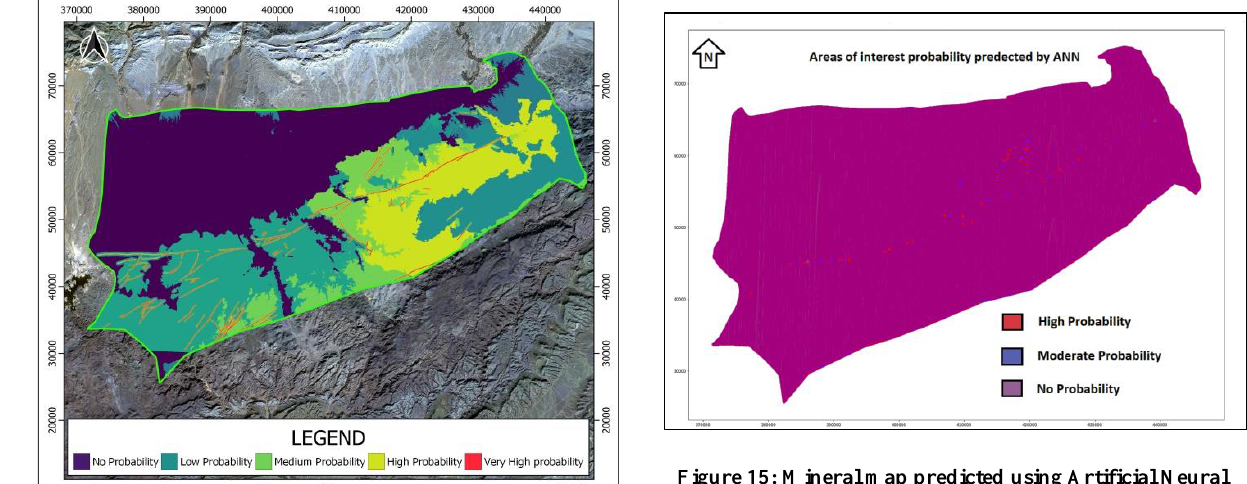
Figure 15: Mineral map predicted using Artificial Neural Network.